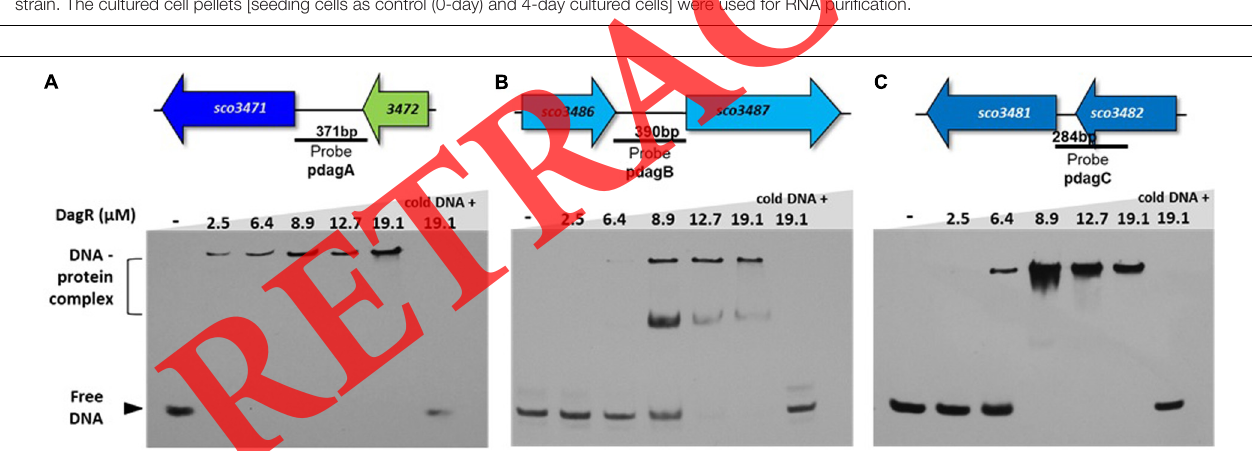
FIGURE 3 | Heatmap of the expression of the agarolytic pathway genes ( sco3471 - 3487 ) depicting fold-changes in the (cid:49) sco3485 mutant compared to the wild type strain. The cultured cell pellets [seeding cells as control (0-day) and 4-day cultured cells] were used for RNA purification.